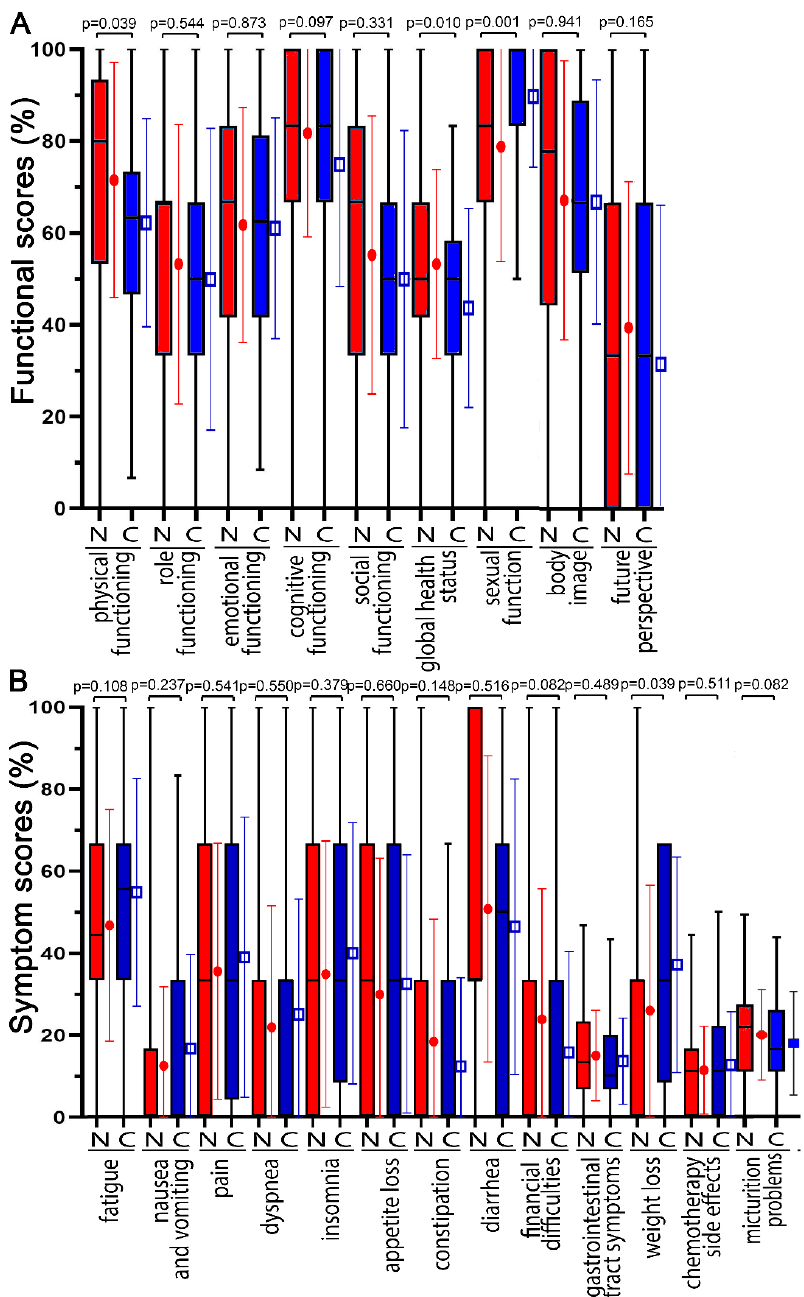
Figure 4. The functional and symptom score distribution of prior to COVID-19 pandemic (N = non COVID) compared with during COVID-19 pandemic (C = during COVID pandemic). Scores were surveyed on day 35 (5 weeks) at the end of radiochemotherapy. ( A ) Functional scores are: physical functioning, role functioning, emotional functioning, cognitive functioning, social functioning, global health status, sexual function, body image, and future perspective. ( B ) Symptom scores are: fatigue, nausea and vomiting, pain, dyspnea, insomnia, appetite loss, constipation, diarrhea, financial difficulties, gastrointestinal tract symptoms, weight loss, chemotherapy side effects, and micturition problems. (cid:3) and • indicate the mean and error bars the standard deviation. There was a clear time dependence of the functions and symptoms. Therefore, the mean scores of the functions and symptoms were plotted over time. The scores related to sexuality were omitted because there were very few responses here (Figure